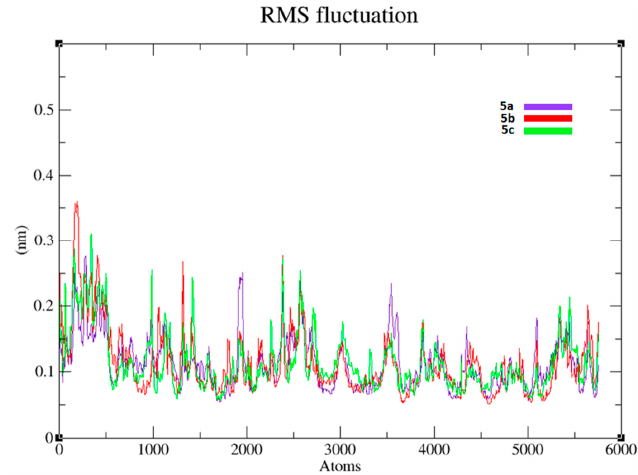
Figure 9. Root Mean Square Fluctuations (RMSF) graph of ( 5a – c ) complexes at different time scale. The backbones with indigo, red and green represent the ( 5a – c ) complexes, respectively.